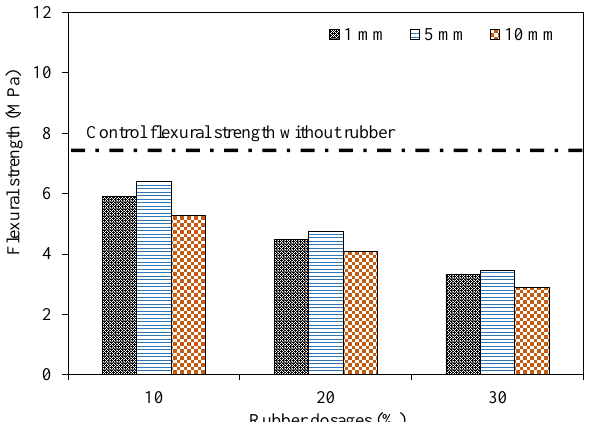
Figure 13. Flexural strength for the mixture incorporating various dosages of rubber at 28 days.